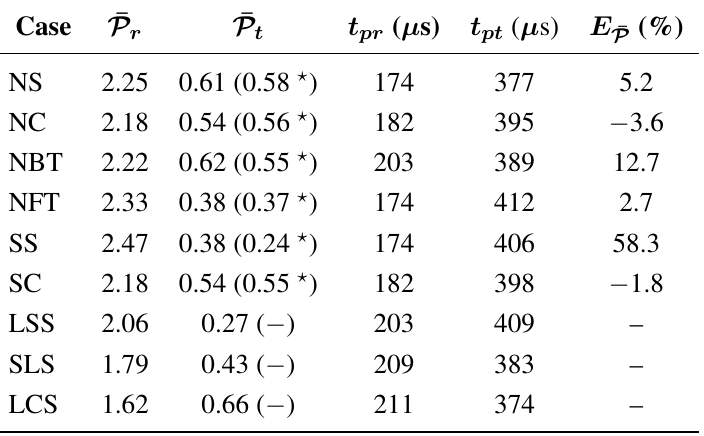
Comparison of time-averaged overpressure ¯ P upstream probe, t , and downstream probe, t pr in